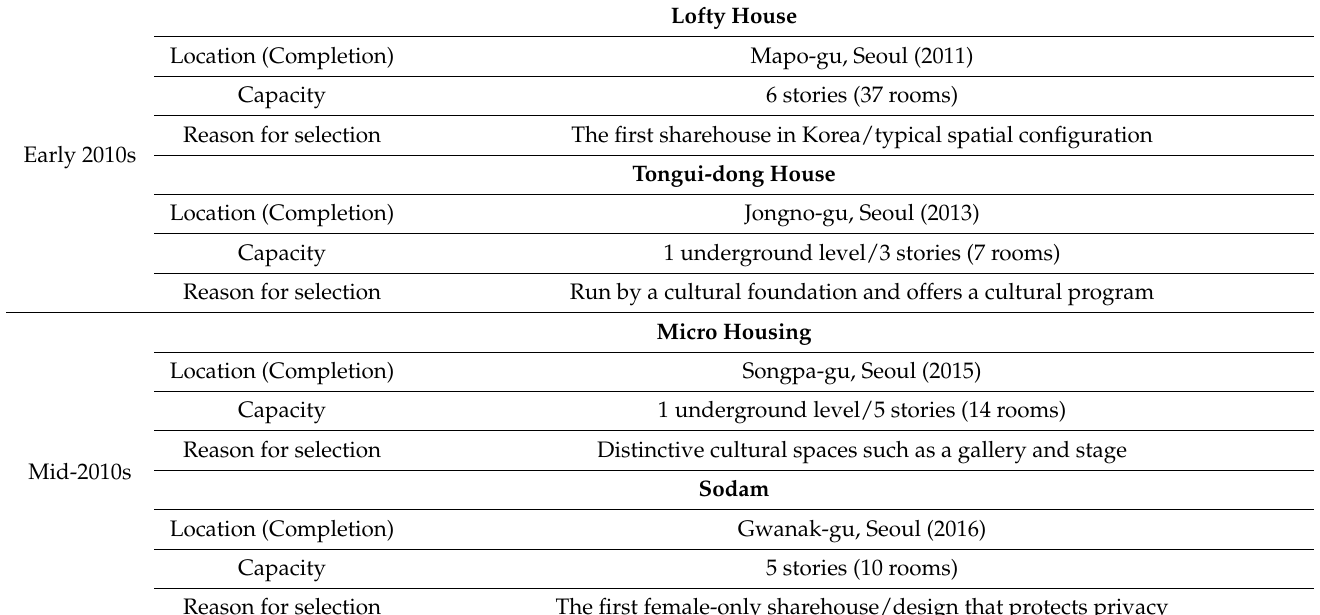
Table 2. The six sharehouse case